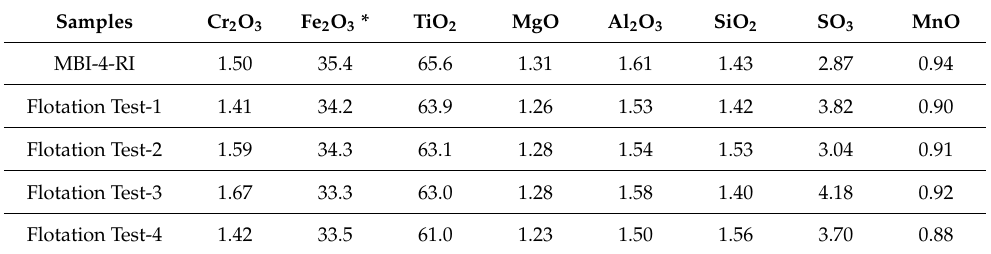
Table 4. XRF analyses of feed and tail samples (Tests 1 to 4) after flotation tests (%wt.).